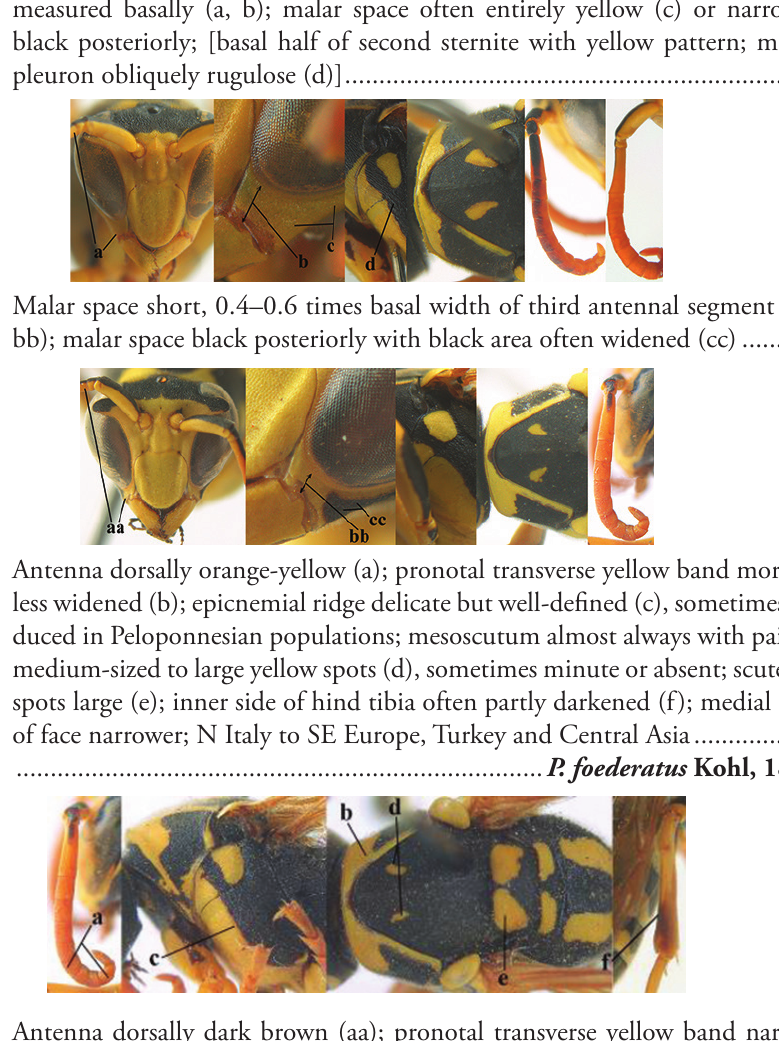
Malar space long, 0.8–1.0 times as long as width of third antennal segment measured basally (a, b); malar space often entirely yellow (c) or narrowly black posteriorly; [basal half of second sternite with yellow pattern; meso- pleuron obliquely rugulose (d)] ................................................................. 30